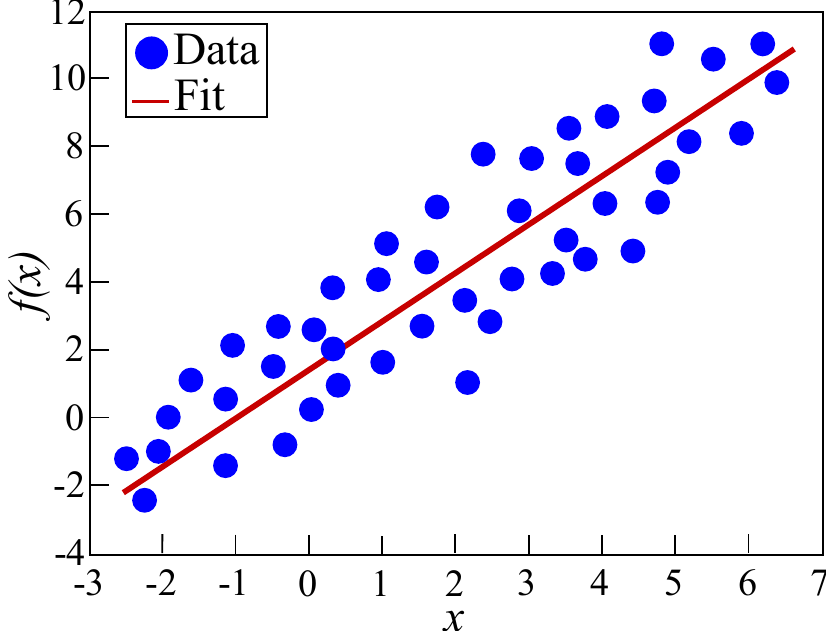
Figure 8. Illustration of the least-squares fitting